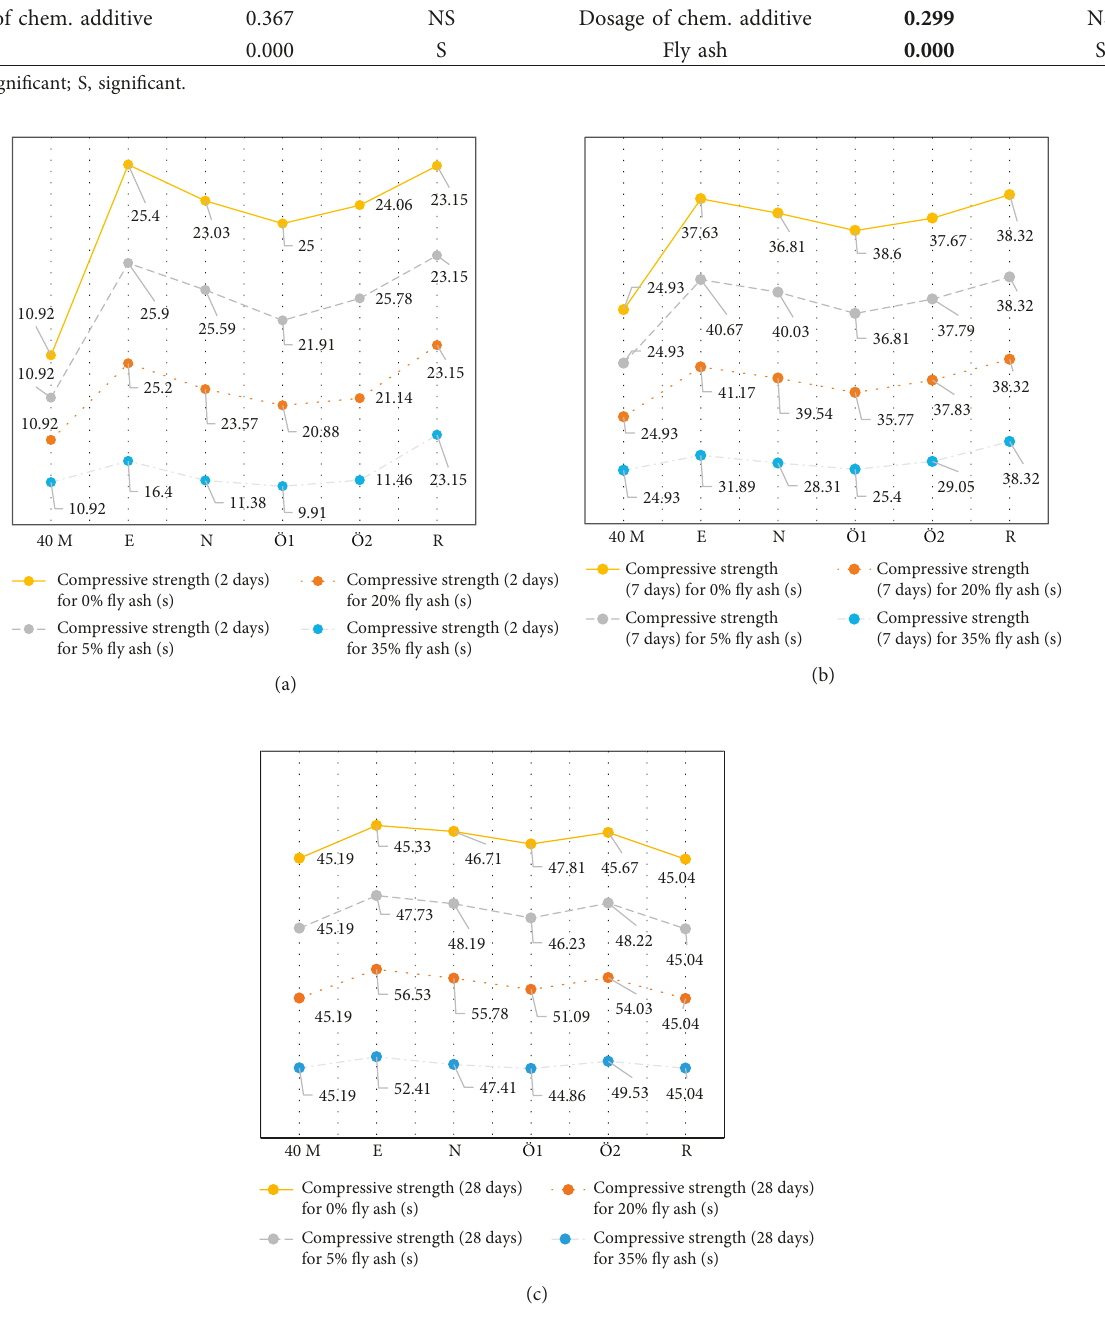
Figure 2: (a) Effect of fly ash ratio on early compressive strength (MPa). (b) Effect of fly ash ratio on 7-day compressive strength (MPa). (c) Effect of fly ash ratio on 28-day compressive strength